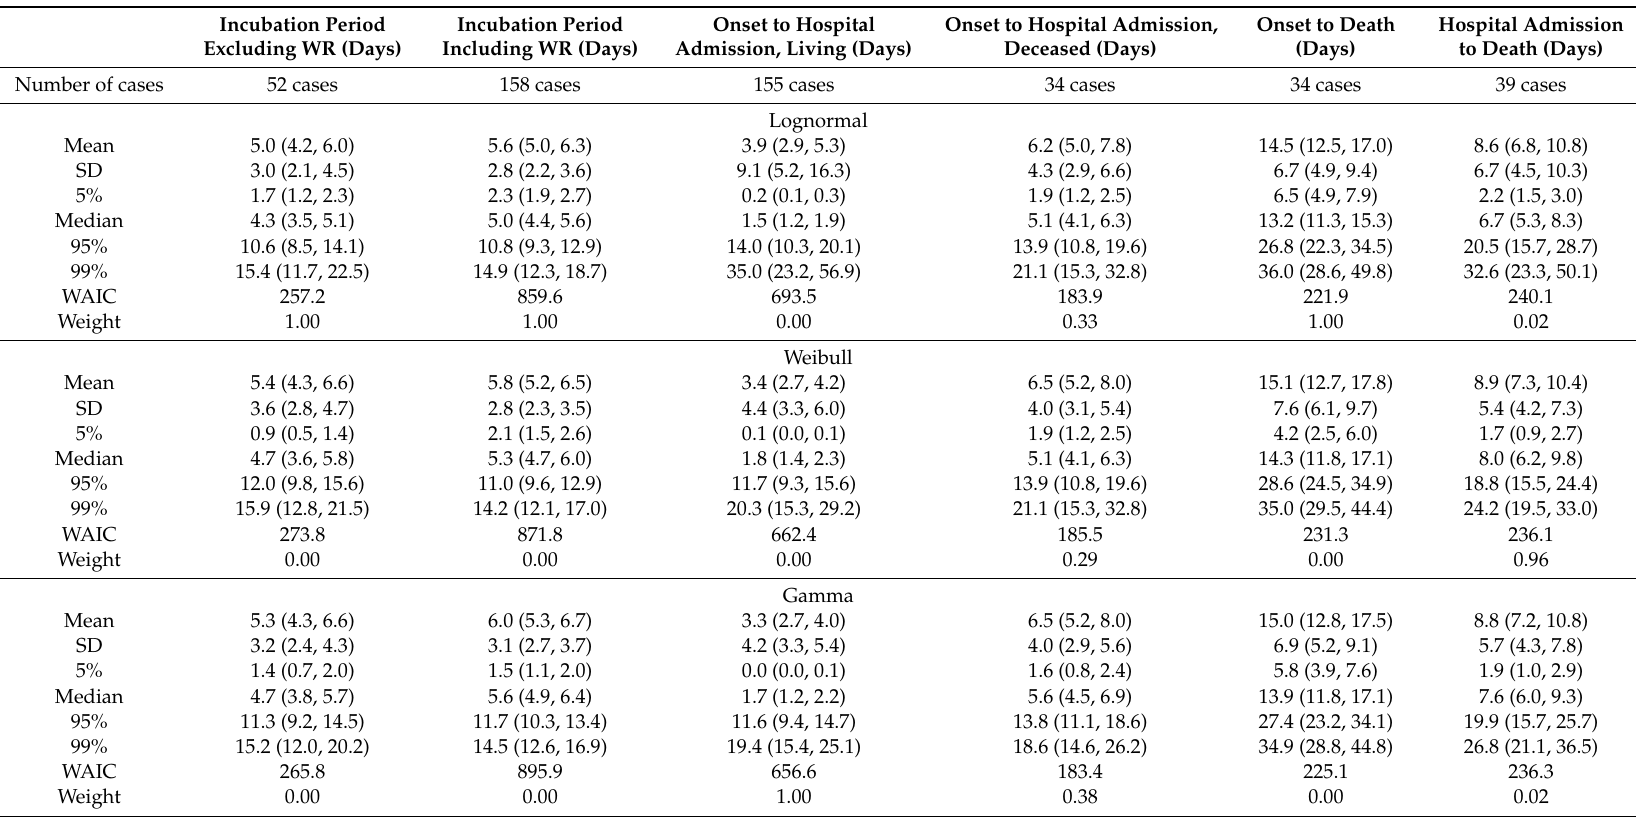
Table 1. Incubation period and other time-delay distributions for COVID-19 outbreak cases reported in January